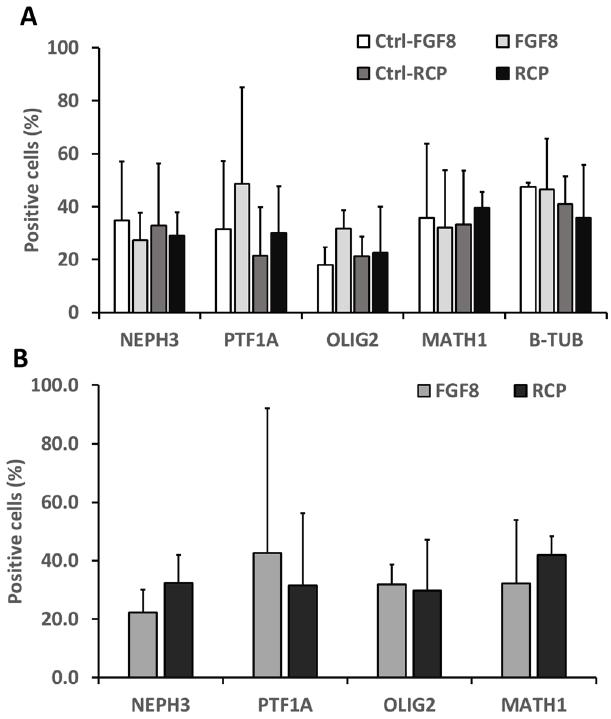
Figure 2. Flow cytometry analysis for the expression of cerebellar markers in the derived cerebellar spheroids. The control condition for the side-by side-comparison with RCP condition is refereed as Ctrl-RCP. The control condition for the side-by side-comparison with FGF8 condition is refereed as Ctrl-FGF8. ( A ) Day 35 RCP condition versus the side-by-side control (Ctrl-RCP) or FGF8 condition versus the side-by-side control (Ctrl- FGF8); ( B ) RCP versus FGF8 condition. The average value and the standard deviation are based on the results from three independent differentiations (each differentiation has the corresponding control